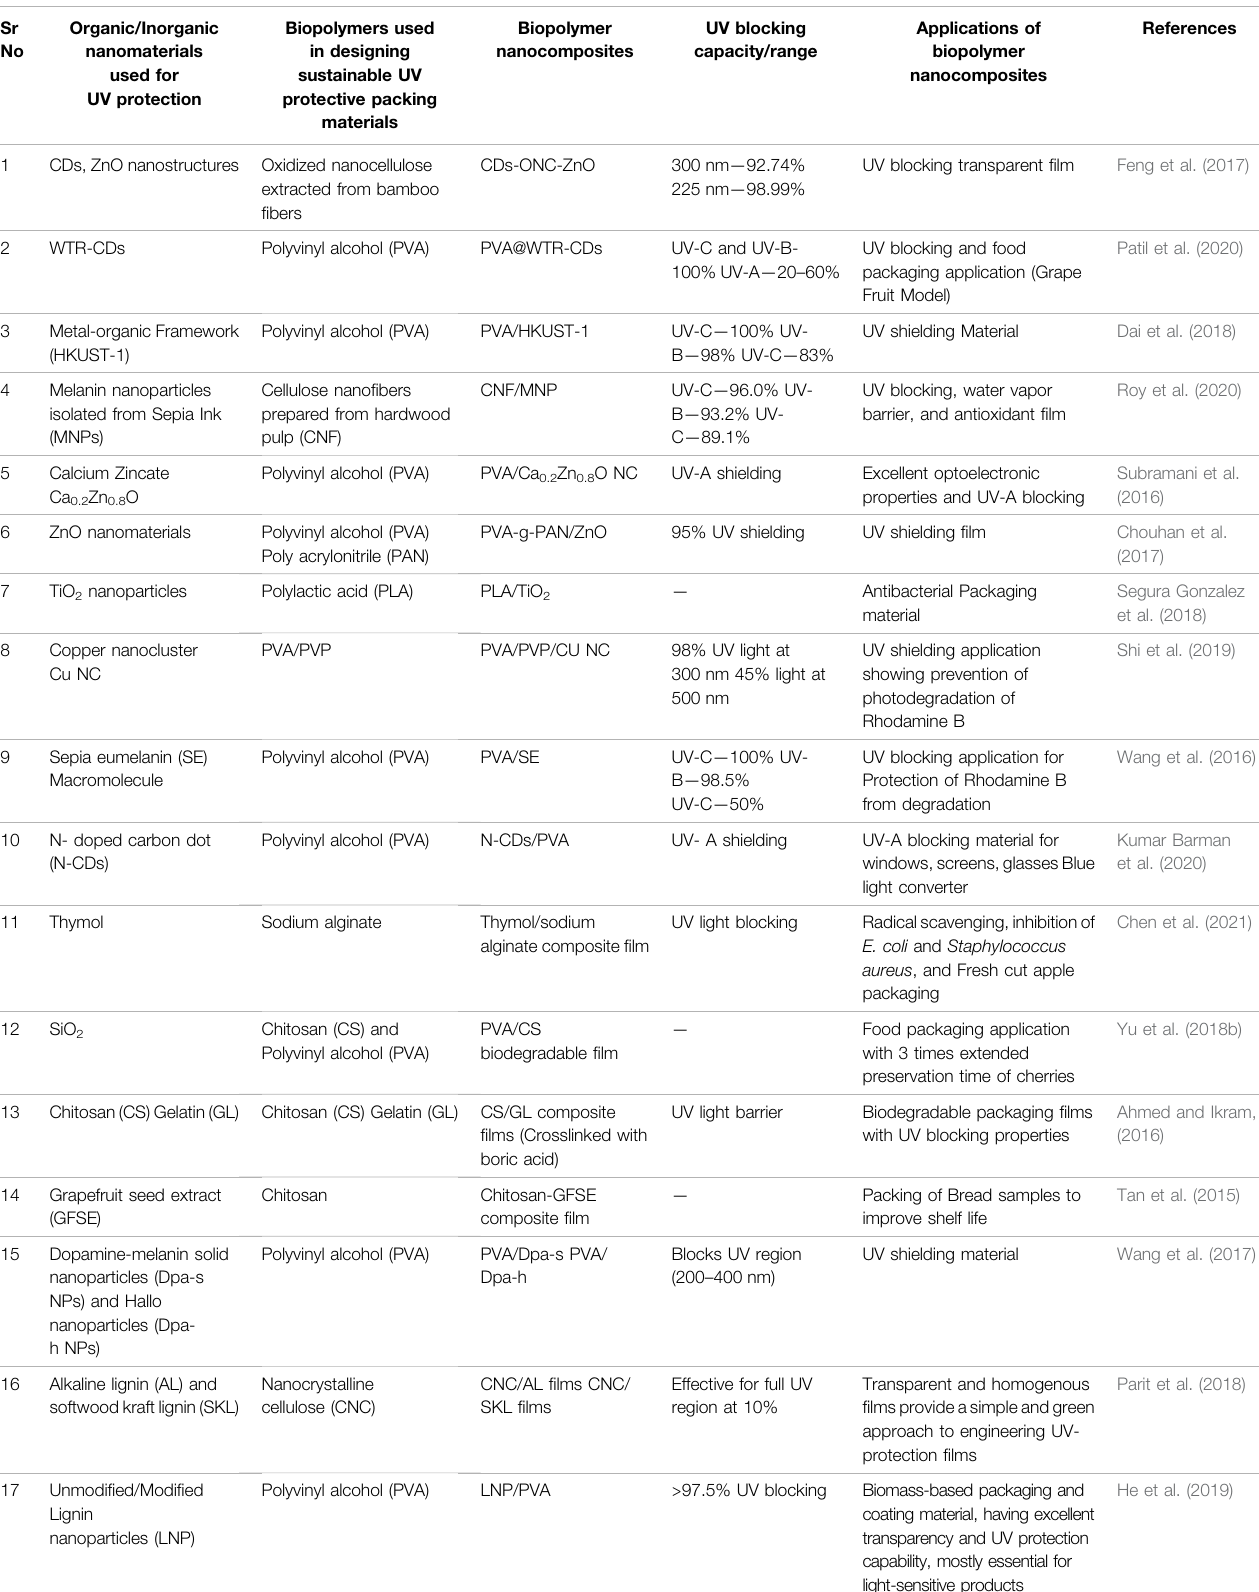
TABLE 2 | Summary of the various biopolymer nanocomposites used for UV protective